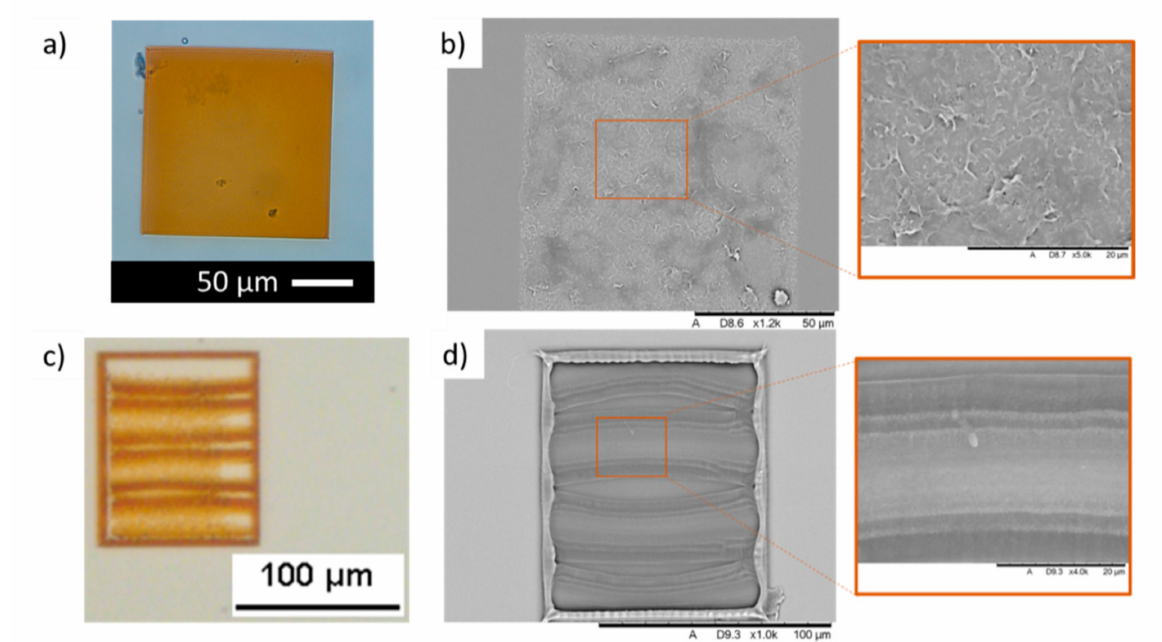
Figure 4. Hydrogel GelMa structures developed by 2PP. ( a ) Optical microscopy and ( b ) SEM imaging of hydrated and dehydrated GelMa ultra-thin films, respectively. ( c ) Optical microscopy and ( d ) SEM imaging of 120 µ m × 100 µ m complex GelMa scaffolds with 10 µ m channels developed by